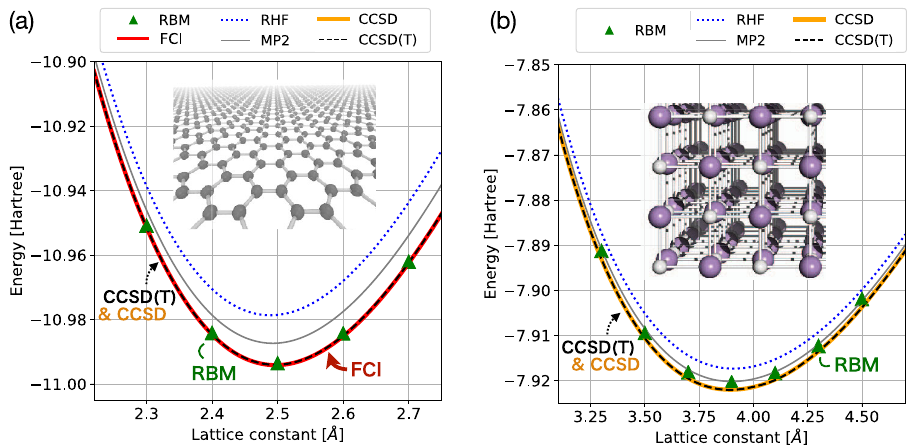
Fig. 3 Potential energy curves for 2D and 3D real solids calculated by neural networks. The ground-state energy is computed for various lattice constants in the vicinity of equilibrium values. a Graphene on a honeycomb lattice solved using the cc-pVDZ basis set. The smallest active space is taken at each 2 × 2 Γ -centered k -point, and hence 16 spin orbitals in total. b LiH with the rocksalt structure solved using the STO-3G basis. The smallest active space is taken at each 2 × 2 × 2 Γ -centered k -point, and hence 32 spin orbitals in total. The result obtained for the RBM state (green triangle) shows remarkable agreement either with the full con fi guration interaction (FCI) method or coupled-cluster singles and doubles with perturbative triple excitations (CCSD(T)), achieving an error within chemical accuracy (1.6 mHa). The red, blue dotted, gray, yellow, and black dashed lines denote the results by the FCI method, restricted Hartree – Fock (RHF) method, second-order Møller – Plesset perturbation theory (MP2), coupled-cluster singles and doubles (CCSD), and